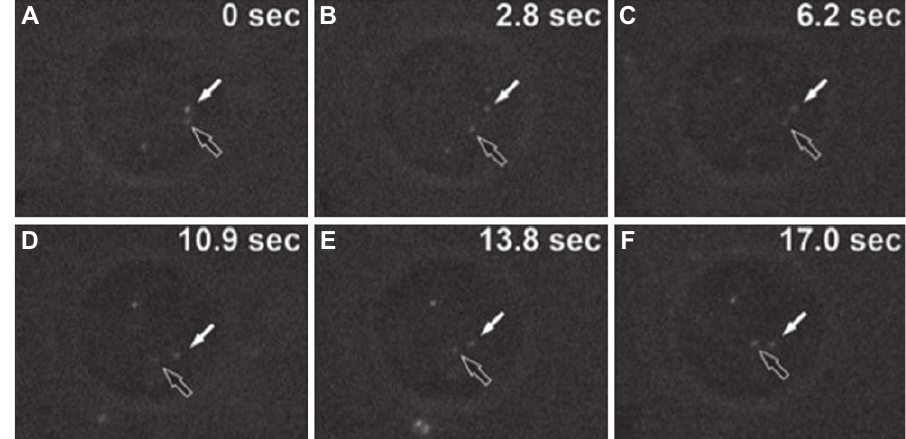
Figure 7 Molecular imaging using dual fl uorescent thiol-organosilica (thiol-OS) nanoparticles composed of quantum dots (QDs) and rho- damine B surface functionalized with anti-CD20 antibody. Raji cells were incubated with dual fl uorescent thiol-OS-QDs functionalized with anti-CD20 antibody. Two dual fl uorescent thiol-OS-QDs (white arrow and black arrow) showed different movements on the Raji cell. From Ref. [67] ; reproduced with kind permission from The Royal Society of